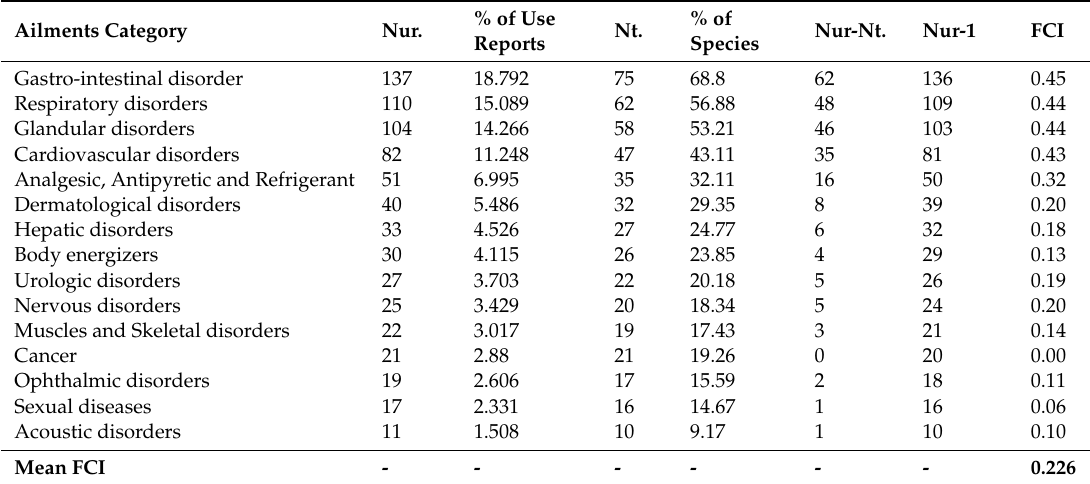
Table 4. Informant consensus factor (FCI) by categories of ailments in the study area.